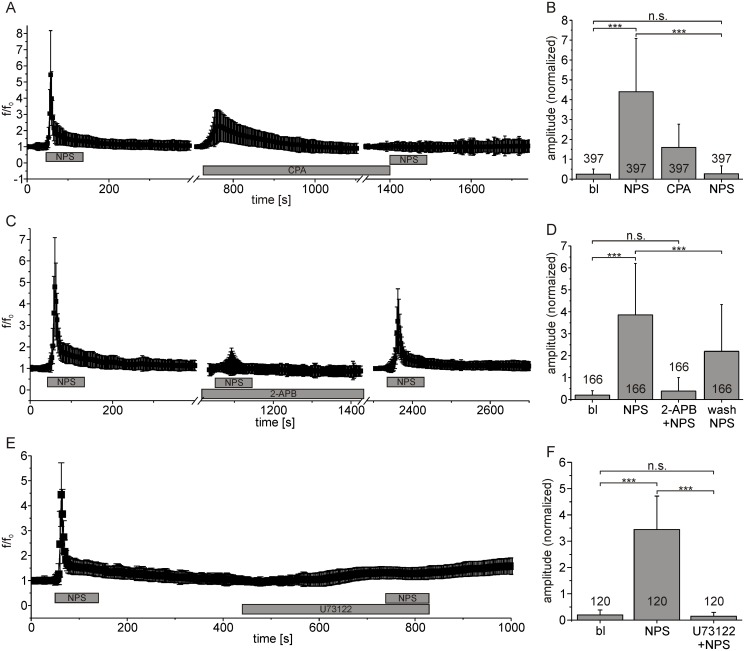
Calcium is released from the endoplasmic reticulum via IP3 receptors upon NPSR1 activation.(A) Normalized mean fluorescence calculated from 397 neurons. NPS and CPA [30 μM] were applied as indicated. CPA abolished NPS-evoked calcium signals. (B) Statistical analysis of peak amplitudes for baseline conditions (bl), NPS, CPA and NPS. (C) Mean fluorescence values from 166 cells treated with NPS and the IP3 receptor antagonist 2-APB [25 μM] as indicated. 2-APB abolished NPSR1-mediated calcium signals. (D) Peak amplitudes for baseline conditions, application of NPS, NPS in presence of 2-APB, and NPS after 2-APB washout calculated from the dataset shown in (C). (E) Mean fluorescence values from 120 cells treated with NPS and the PLC-blocker U73122 [10 μM]. The drug abolished NPSR1-mediated calcium signals. (F) Peak amplitudes for baseline conditions, application of NPS, and NPS in presence of U73122 calculated from the dataset shown in (E). NPS was used at 500 nM in all experiments.